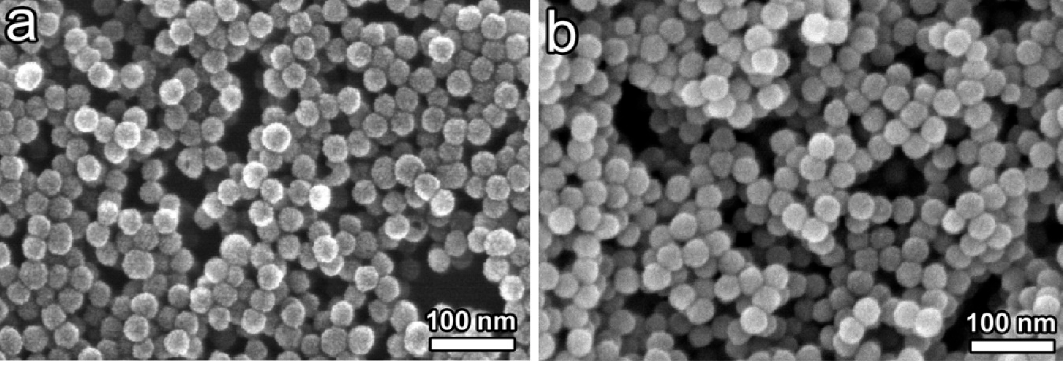
Figure 5. Field electron scanning electron microscopy (FE-SEM) of A 4 [Re 6 Q 8 L 6 ]@SiO 2 NPs, ( a )